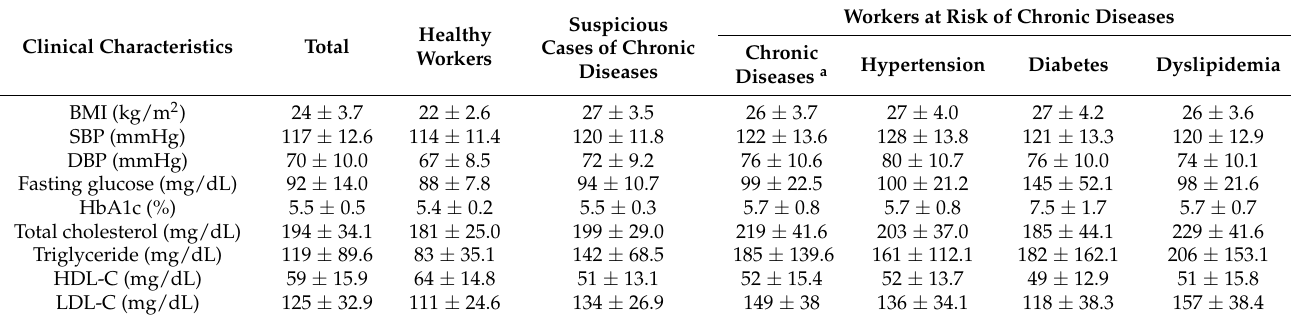
Table 3. Clinical characteristics of employees of the semiconductor/liquid crystal display (LCD) company according to risk levels of chronic diseases (mean ±